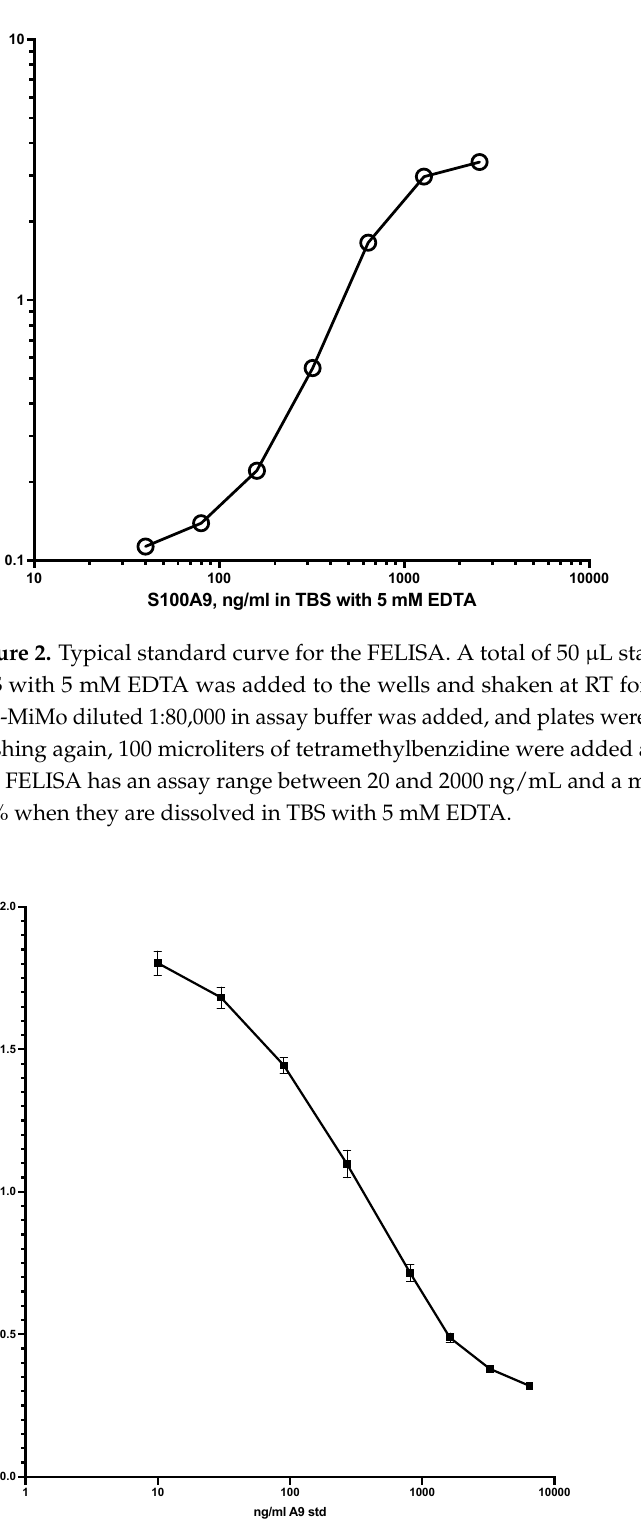
Figure 3. This shows the standard curve for the competitive ELISA. The plate was coated with S100A9 at 5 µg/mL in TBS with 5 mM EDTA pH 7.4, 50 µL per well, overnight at 5C. After washing, 50 µL standard or diluted samples was added to the wells, shaken at RT for 40 min, and washed again. Then, 50 µL HRP-MiMo diluted 1:80,000 was added, left for 20 min at RT, and washed again before adding substrate, and reading at 450 nm after 15 min. CVs were from 1.9 to 4.1. Figure 4 shows the peaks obtained when an IBD patient stool extract, prepared by use of a CalproLab kit, was run on the Q-sepharose chromatographic column. The frac- tions were run on a CalproLab ELISA kit and on the MiMo ELISA. Up to ten fractions, differing in net negative electric charge, were eluted from the column, and most of them reacted much stronger with the MiMo ELISA than the CalproLab kit, suggesting that the antibodies in the latter do not detect properly fecal CP in all fractions.